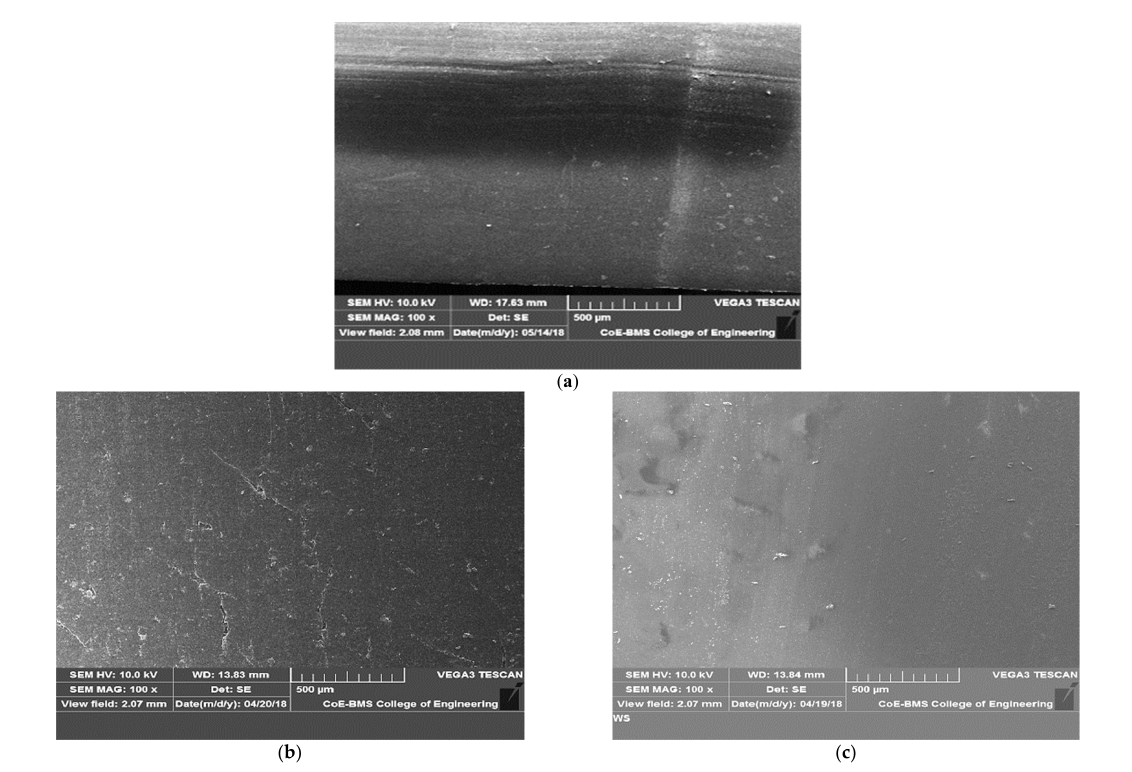
Figure 6. Scanning electron micrographs of the wear test specimens showing the morphology the surfaces before the friction and wear test. ( a ) Pure ABS; ( b ) ABS + 2.5 wt% graphite; ( c ) ABS + 5 wt% graphite.